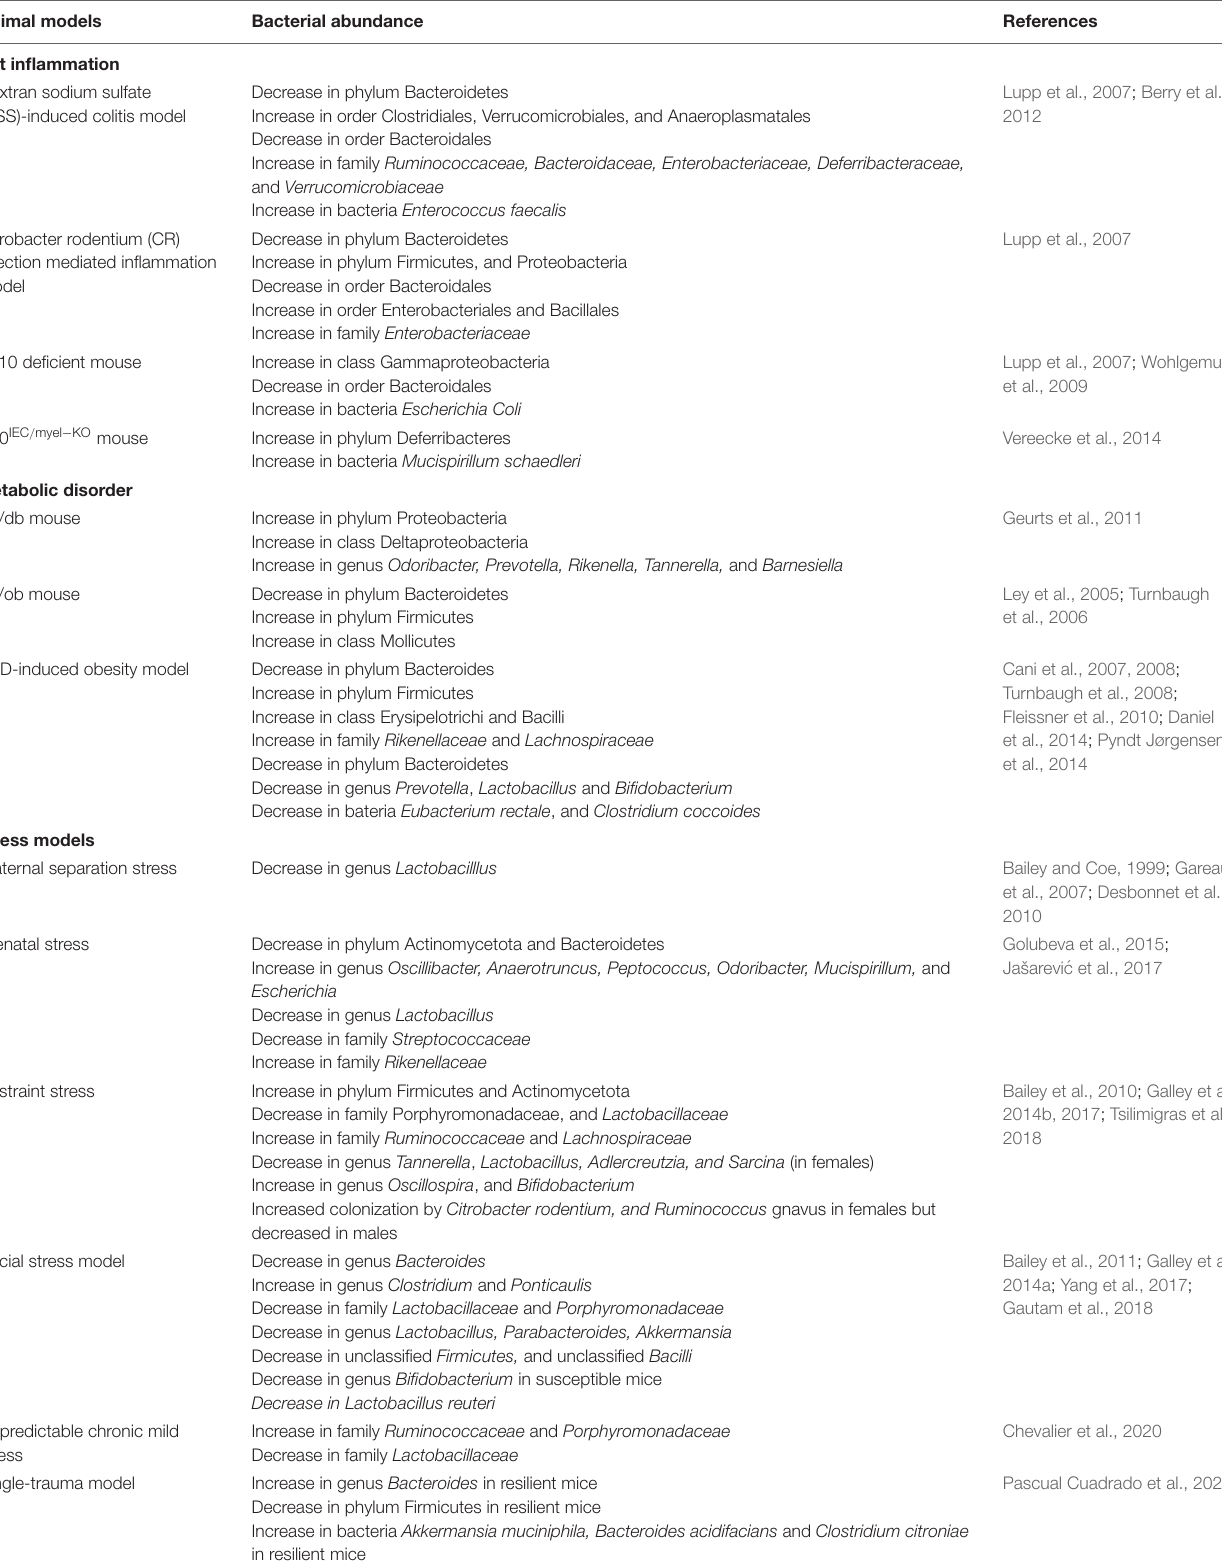
TABLE 1 | Changes in the microbiota composition associated with different pathological conditions in animal models. Animal